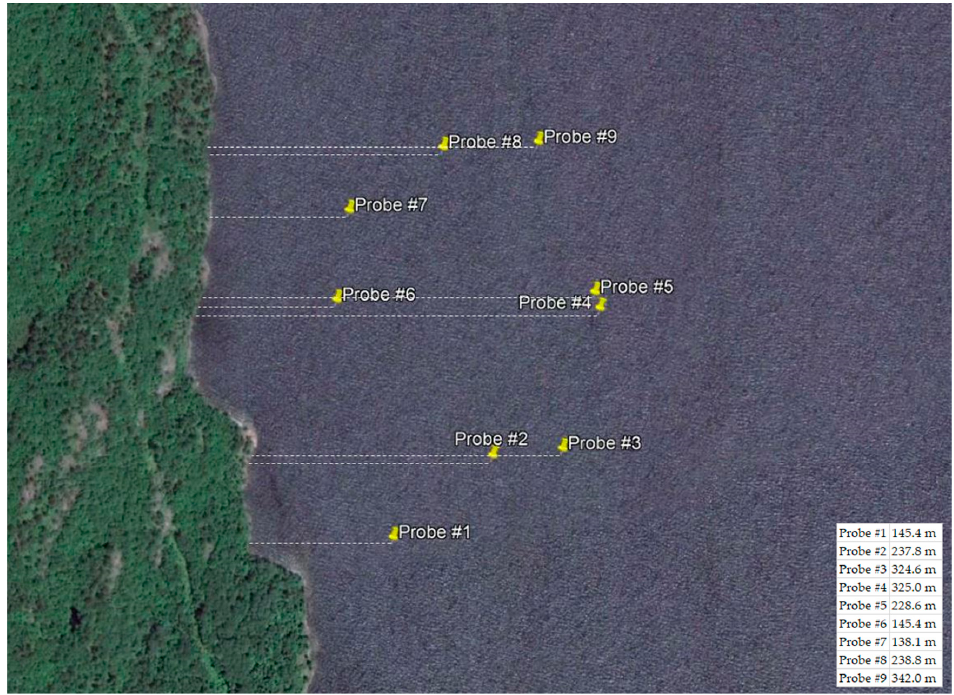
Figure 7. Satellite image showing probe locations and distances from the shoreline.